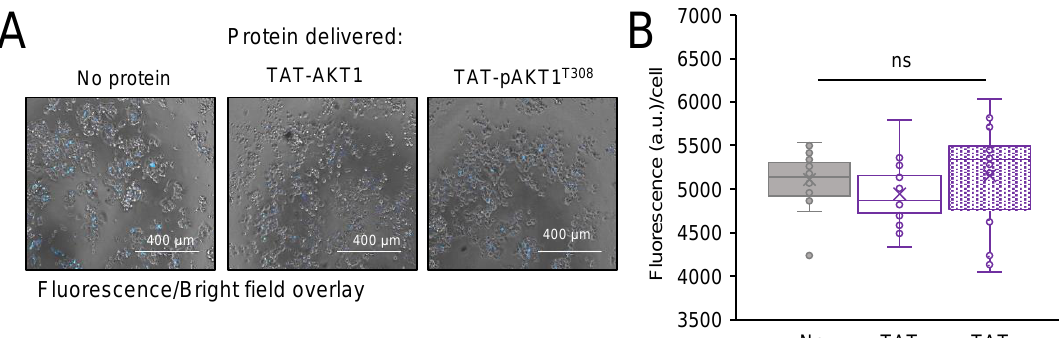
Figure 8. TAT-AKT1 protein delivery is non-toxic to HEK 293T cells. Cytotoxicity was measured after a 24-hour incubation with no protein (buffer only), TAT-AKT1, or TAT-pAKT1 T308 by staining dead cells with Sytox blue in three biological replicates. ( A ) Images of cells with Sytox blue staining of dead cells. ( B ) Quantification of dead cells shows no significant impact of TAT-AKT1 and TAT-pAKT1 T308 protein delivery compared to cells treated with buffer only (no protein). Significance was calculated by one-way ANOVA (ns — not significant).